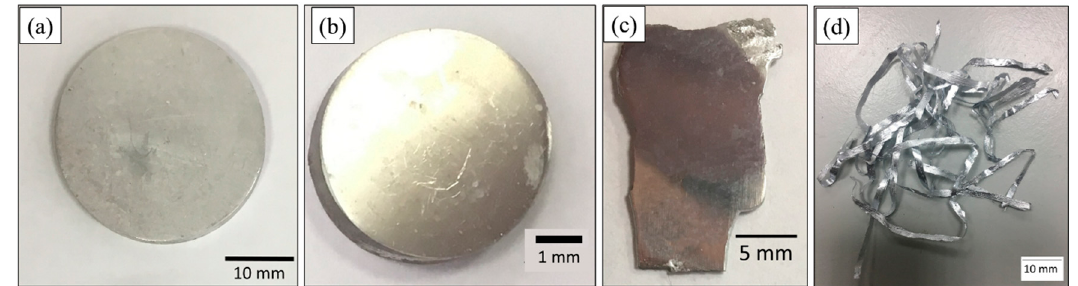
Figure 1. Experimental cast samples and melt-spun ribbons: ( a ) 30 mm cast sample; ( b ) 5 mm cast sample; ( c ) 1 mm cast sample; ( d ) melt-spun ribbon.